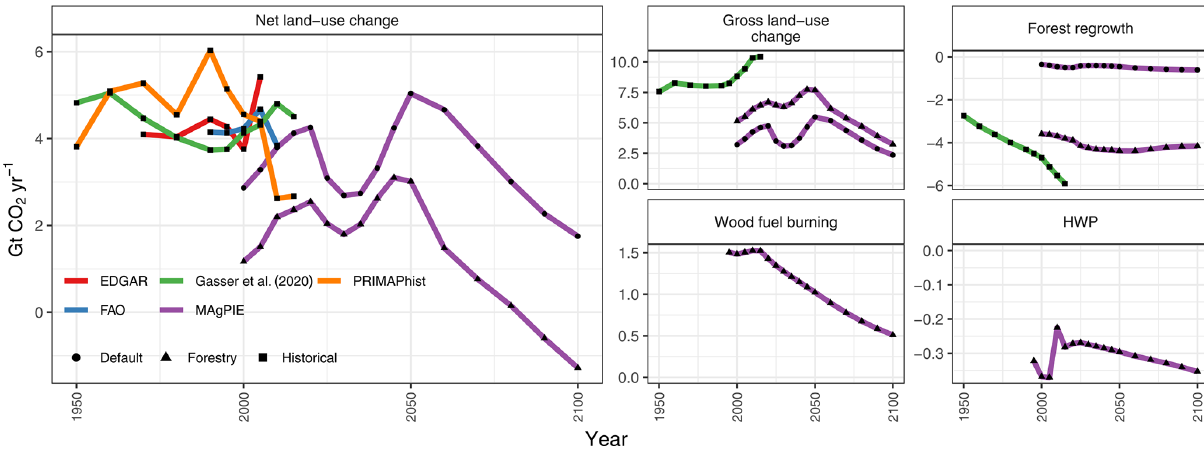
Figure 17. Global annual land-use change emissions (in GtCO 2 yr − 1 ; 1995–2100) and their components. Validation data were sourced from the Emissions Database for Global Atmospheric Research (EDGAR; JRC and PBL, 2010), FAO (2017), Gasser et al. (2020), Houghton et al. (2012), Potsdam Real-Time Integrated Model for Probabilistic Assessment of Emission Paths (PRIMAPhist; Gütschow et al., 2016), Lauk et al. (2012), and Johnston and Radeloff (2019). The regional distribution is available in Fig.